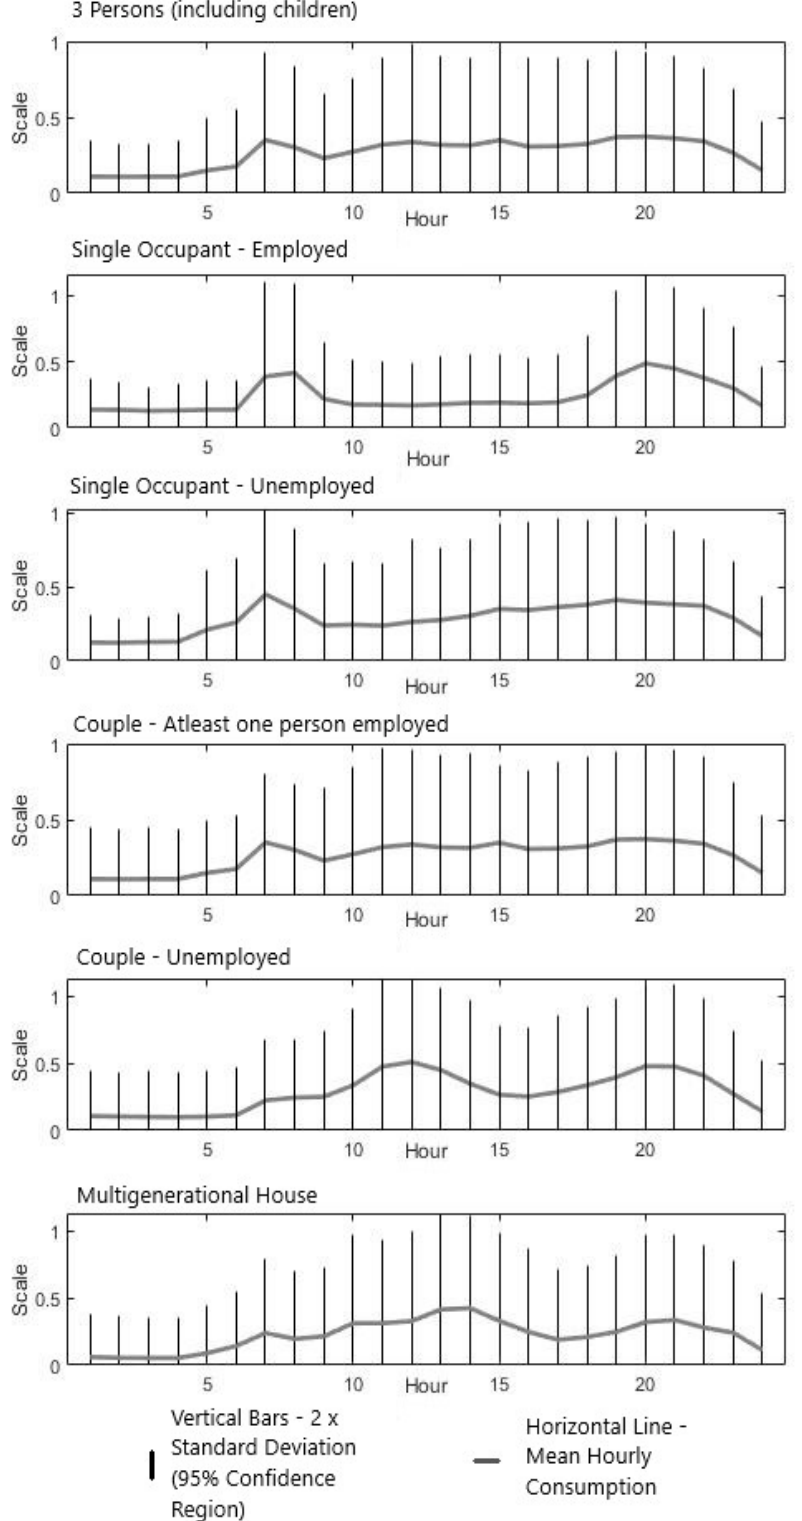
Figure 2. Possibility curves for considered household types showing average loading and possible values in a 95% confidence interval.